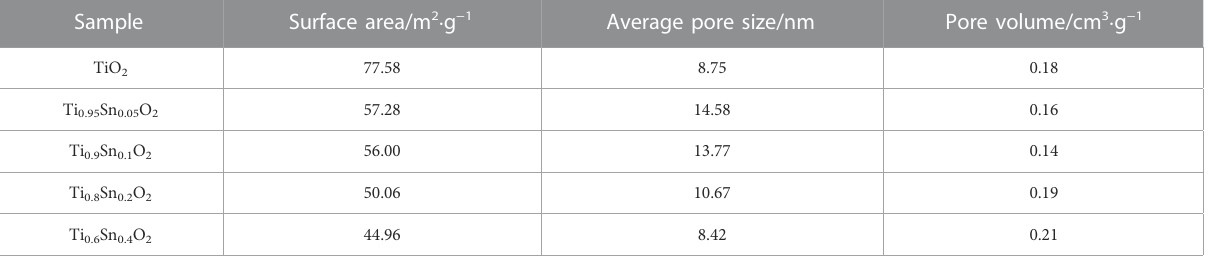
TABLE 2 The parameters of pore structure in pure TiO 2 and Ti 1-x Sn x O 2 (0 < x ≤ 0.4).